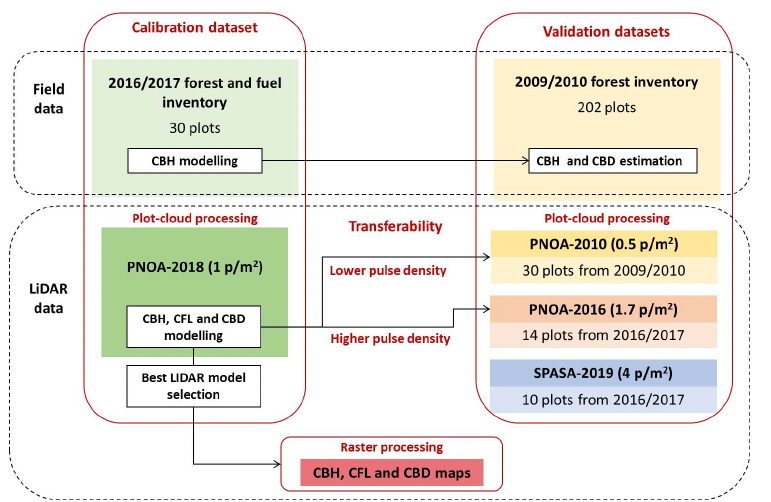
Figure 2. Conceptual diagram of the methods used for canopy fuel modelling and transferability assessment.